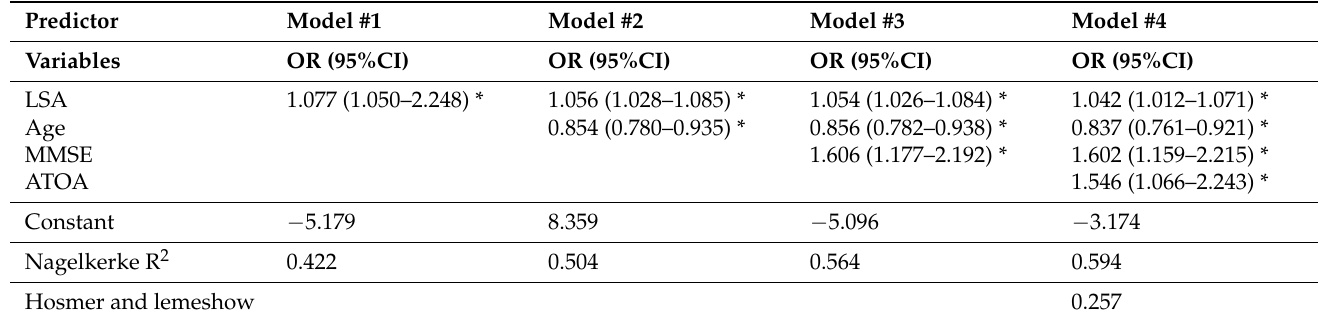
Table 2. Logistic regression model, using forward (likelihood ratio) stepwise entry